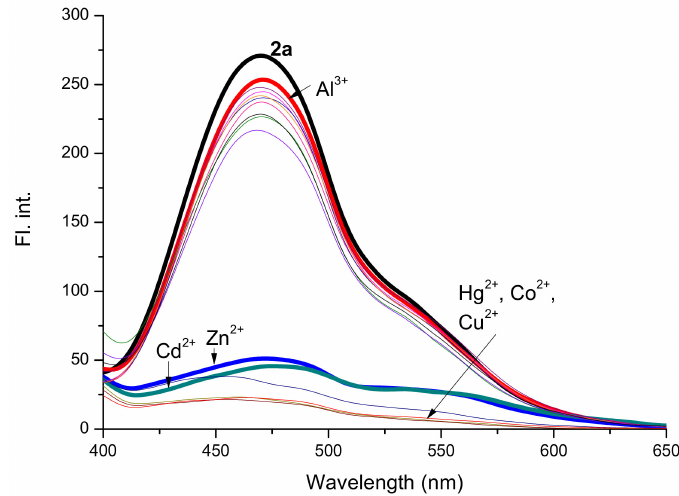
Figure 2. Fluorescence spectra of 2a (10 µ M) recorded with or without 2 equiv. of metal ions (Al 3+ , Zn 2+ , Cd 2+ , Ag + , Co 2+ , Ni 2+ , Cu 2+ , K + , Pb 2+ , Mg 2+ , Na + , Ca 2+ , Fe 2+ , Fe 3+ , and Hg 2+ ) in PBS buffer (10 mM, pH 7.2) containing 50% MeOH.